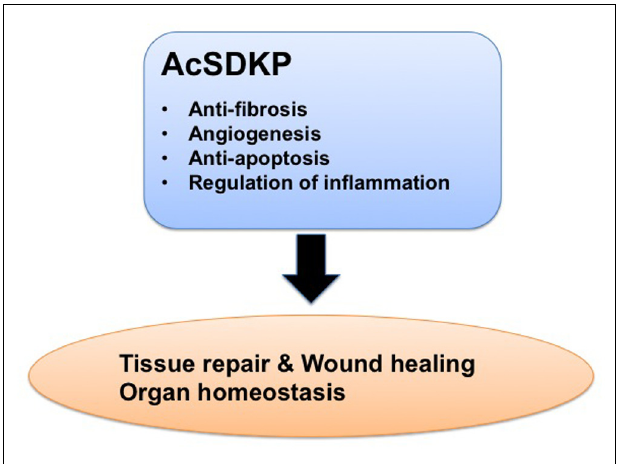
FIGURE 6 | Beneficial effects ofAcSDKP in the process of tissue repair. AcSDKP exhibits multiple functions shown above, such as regulation of inflammation as well as anti-fibrotic, anti-apoptotic, and pro-angiogenic activities.Therefore, AcSDKP could be a candidate target molecule to combat kidney fibrosis in